Question: Is the quantity shown trending increasing or decreasing?
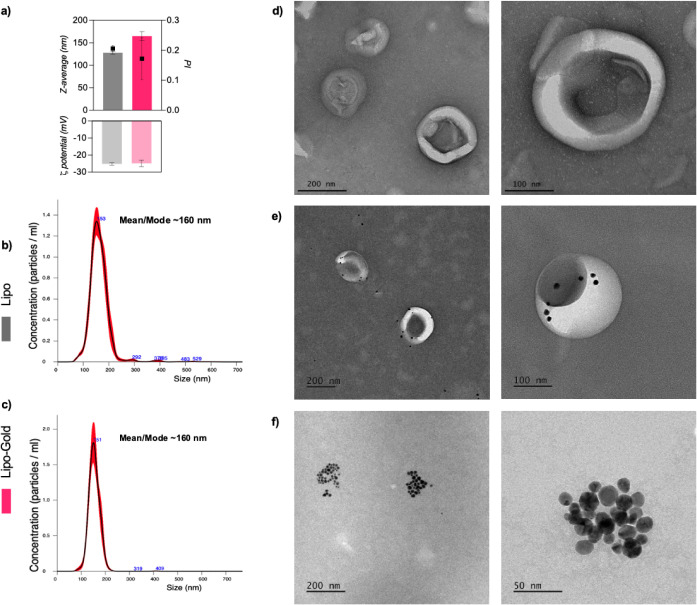
Answer: increasing